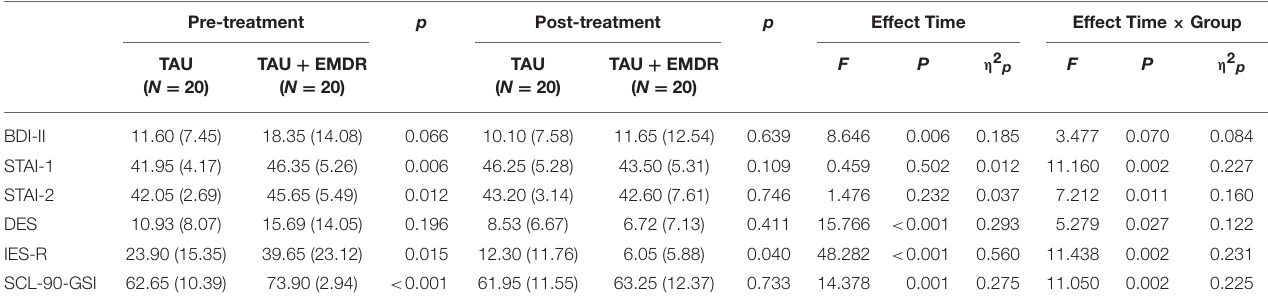
TABLE 2 | Comparison of clinical variables for the two groups (TAU and TAU + EMDR).